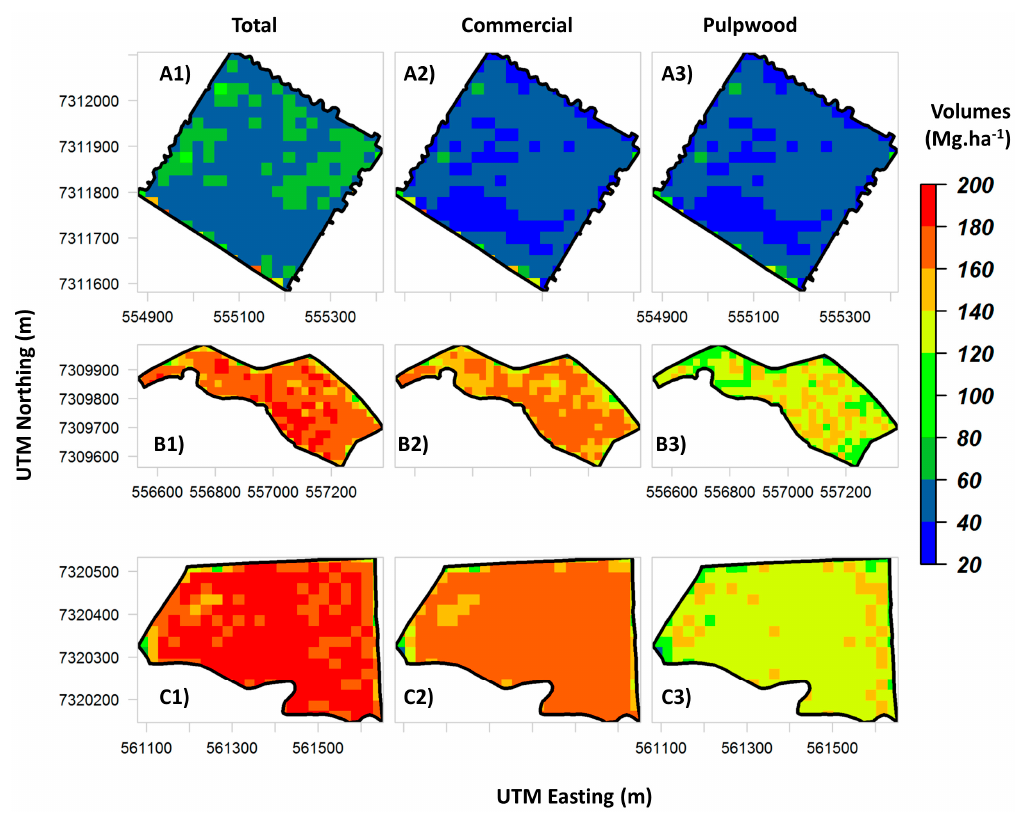
Figure 7. Predicted Vt ( A1 – C1 ), Vc ( A2 – C2 ) and Vp ( A3 – C3 ) of P. taeda at stand-level obtained from the RF models. Representative stand of early (i.e., 3–5 years) ( A1 – 3 ), intermediate (i.e., 5–7 years) ( B1 – 3 ) and advanced-stages of development (i.e., 7–9 years) ( C1 – 3 ).